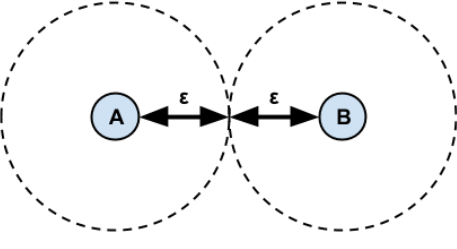
Figure 2. Minimum distance between two points to characterize proximity. Source: the